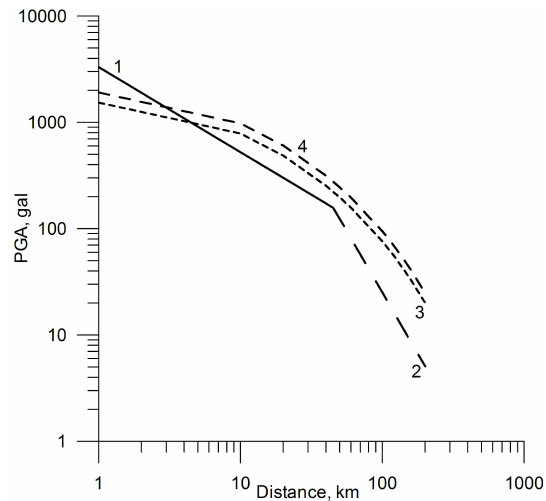
Fig. 3. PGA vs. the distance from an earthquake hypocenter com- puted for events of magnitude 6.5. Curves 1 and 2 mark the “near” and “far” events in Baku and are plotted using the formulas Eq. (1) and Eq. (2), respectively. Curves 3 and 4 mark the intra-plate events in Japan occurred at the depths of 33km and 55km, respectively, and are plotted using the formula Eq. (3). See text for